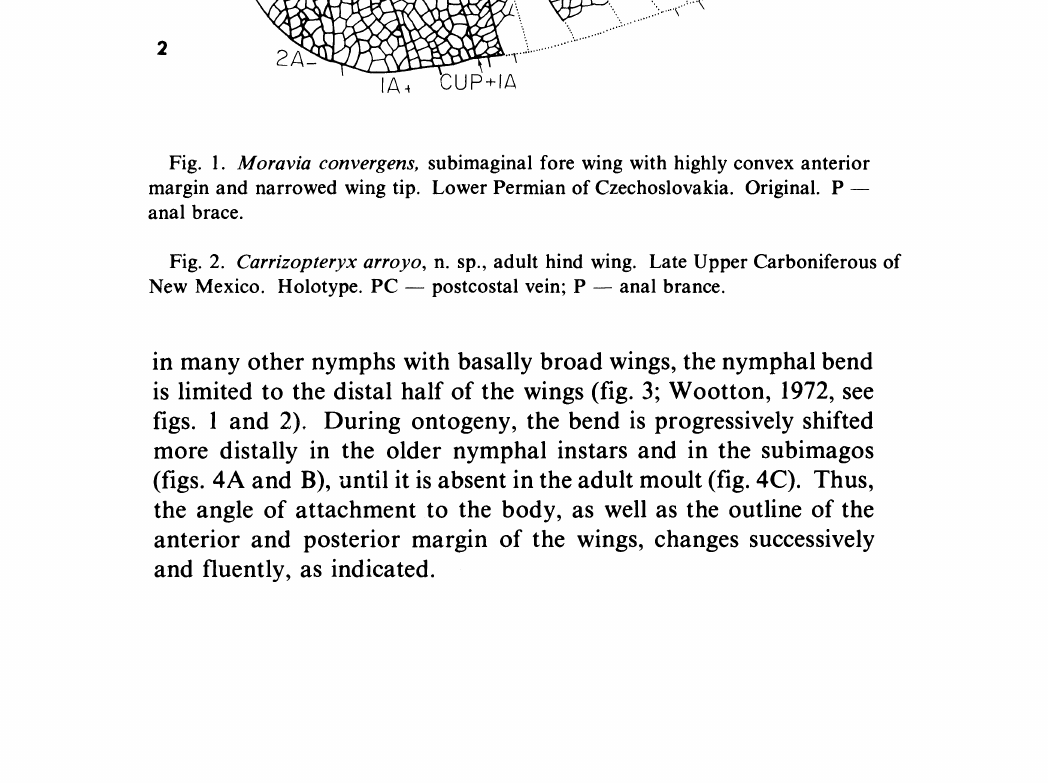
Fig. 1. Moravia convergens, subimaginal fore wing with highly convex anterior margin and narrowed wing tip. Lower Permian of Czechoslovakia. Original. P anal brace. Fig. 2. Carrizopteryx arroyo, n. sp., adult hind wing. Late Upper Carboniferous of New Mexico. Holotype. PC postcostal vein; P anal